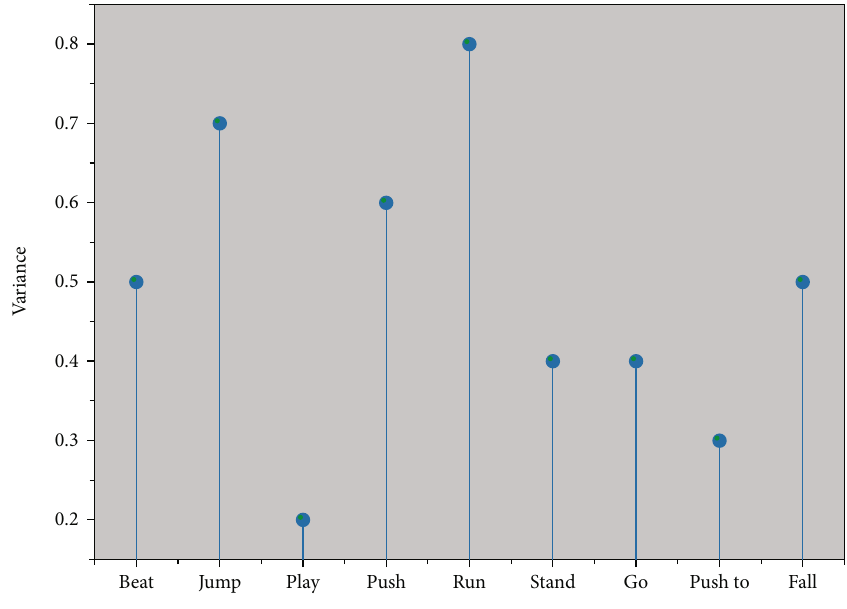
Figure 4: Quartile plot of y -axis variance characteristics of waist